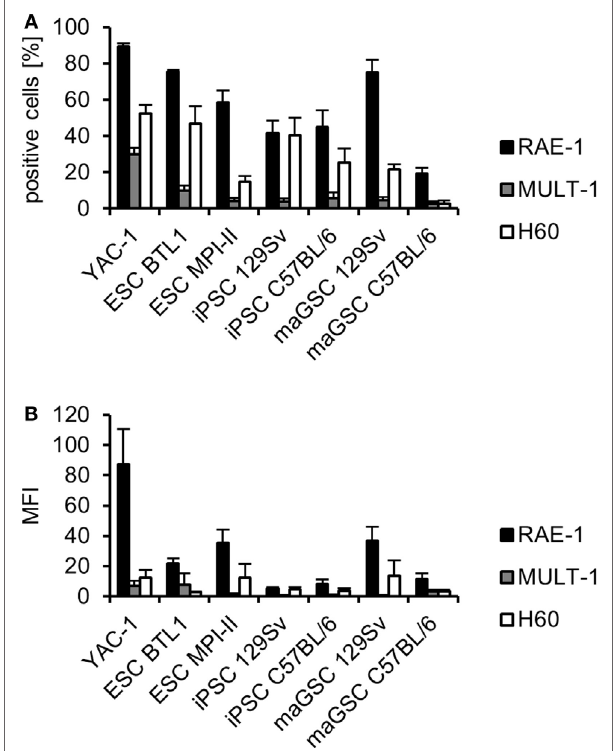
FigUre 5 | Analysis of the expression of NKG2D ligands on target cells. (a) The percentage of cells expressing the indicated NKG2D receptor ligands (mean plus SEM) is shown as determined by flow cytometry in 3–13 individual experiments [YAC-1: n = 13, embryonic stem cell (ESC) BTL1: n = 3, ESC MPI-II: n = 7, induced pluripotent stem cell (iPSC) 129Sv: n = 5, iPSC C57BL/6: n = 7, multipotent adult germline stem cell (maGSC) 129Sv: n = 6, maGSC C57BL/6: n = 7]. (B) The mean fluorescence intensity has been determined in parallel and is displayed plus SEM.